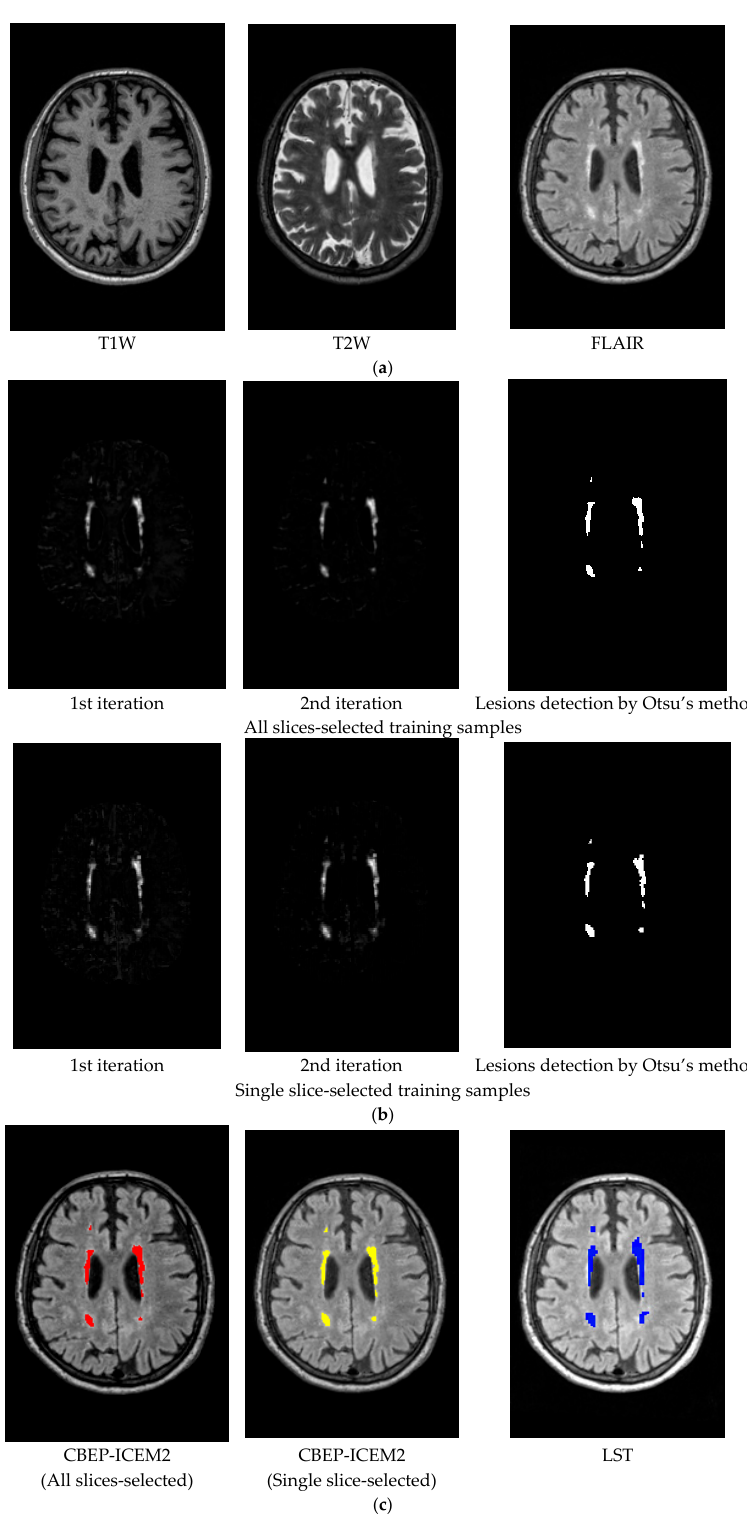
Figure 12. Lesion detection of Fazekas grade 1 by CBEP-ICEM2 and LST ( a ) Original MR images (T1W, T2W, FLAIR) with lesions of Fazekas grade 1; ( b ) CBEP-ICEM2-detected lesion of Fazekas grade 1; ( c ) Comparison between lesion detections by CBEP-ICEM2 and LST.